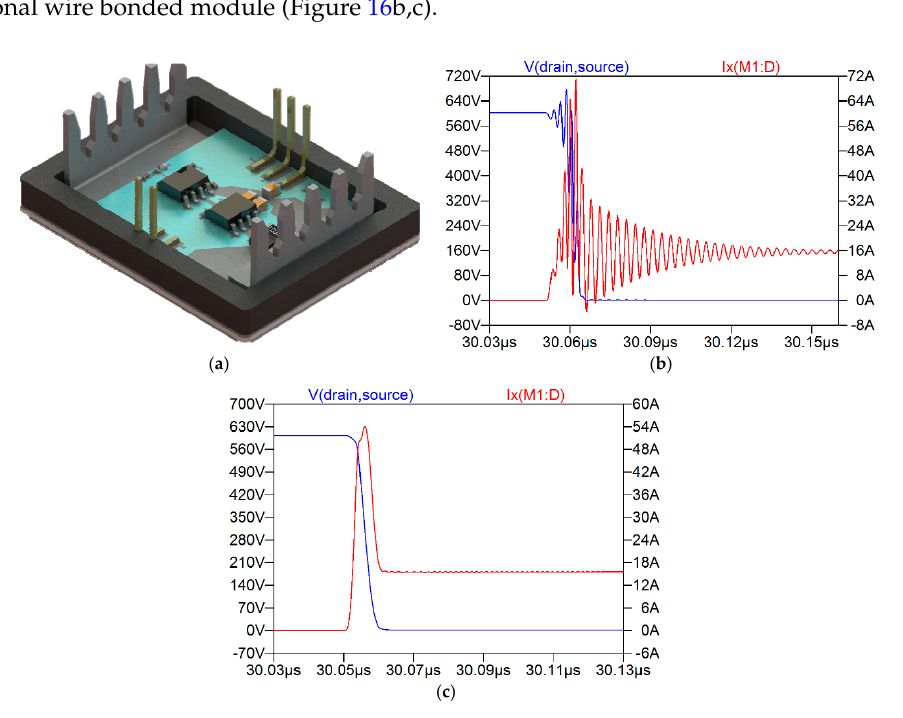
Figure 15. The LTCC based integrated wire bondless power module by Seal et al. [74].